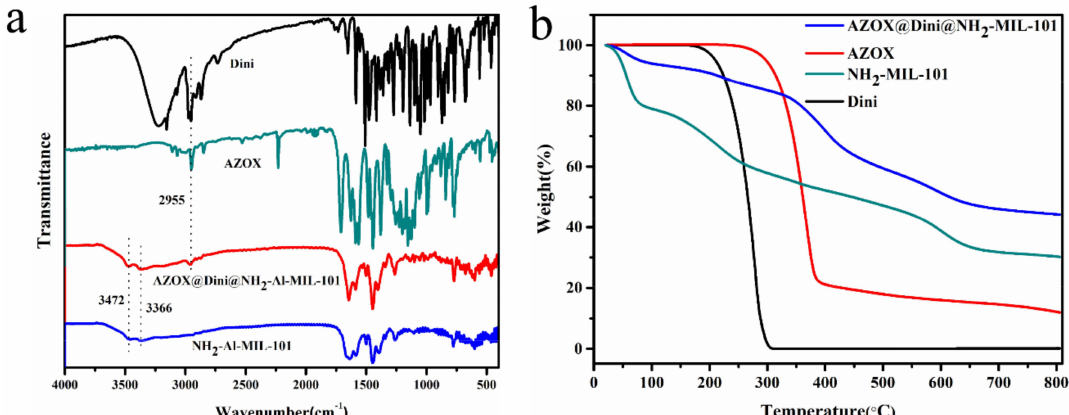
Figure 3. Fourier transform infrared (FTIR) spectra ( a ) and thermogravimetric analyses (TGA) ( b ) of azoxystrobin (AZOX) and diniconazole (Dini) standards, NH 2 -Al-MIL-101, and AZOX@Dini@NH 2 -Al-MIL-101.